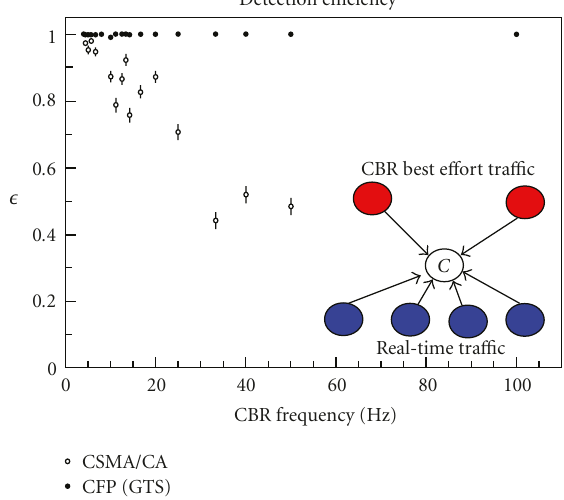
Figure 28: E ffi ciency as a function of the CBR rate of two disturbing nodes for the case of CSMA/CA (empty markers) and the GTS (filled